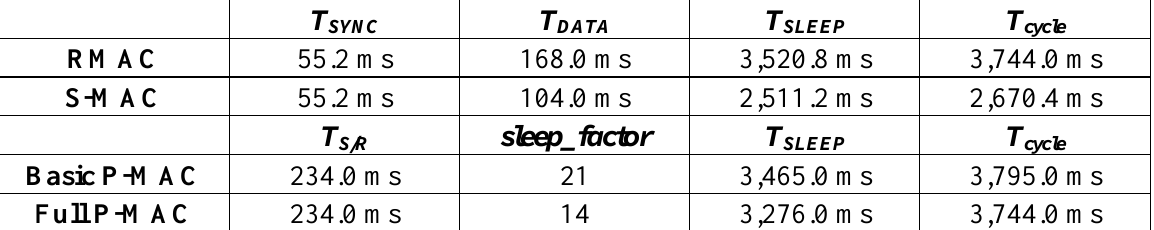
Table 3. Cycle Duration Parameters.